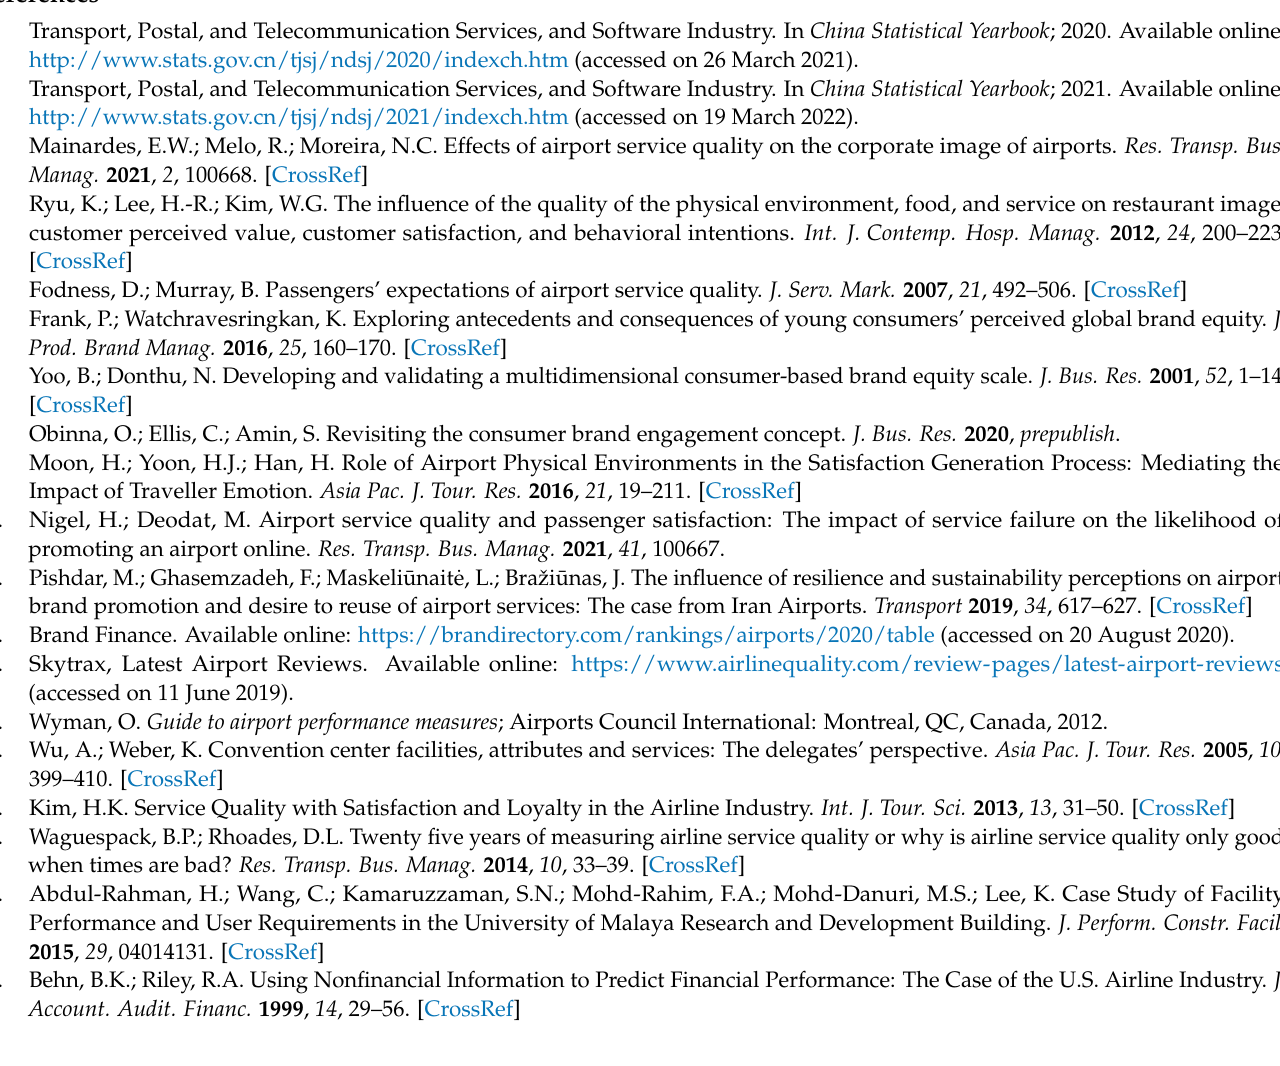
Not Very Satisfied